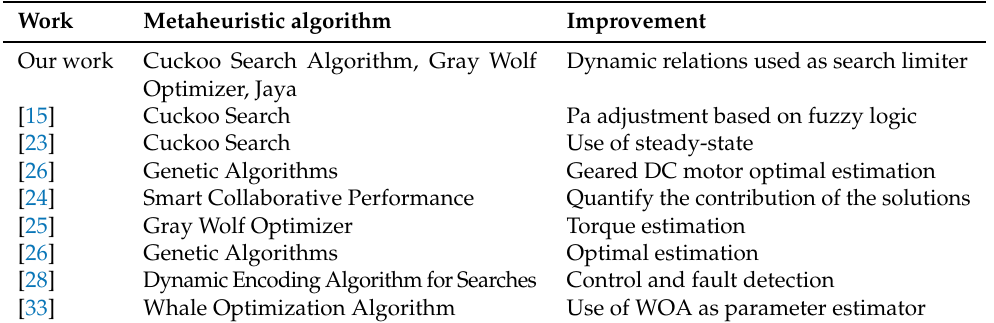
Table 1. Comparison of parameter estimation of DC motor with metaheuristics algorithms in similar works.